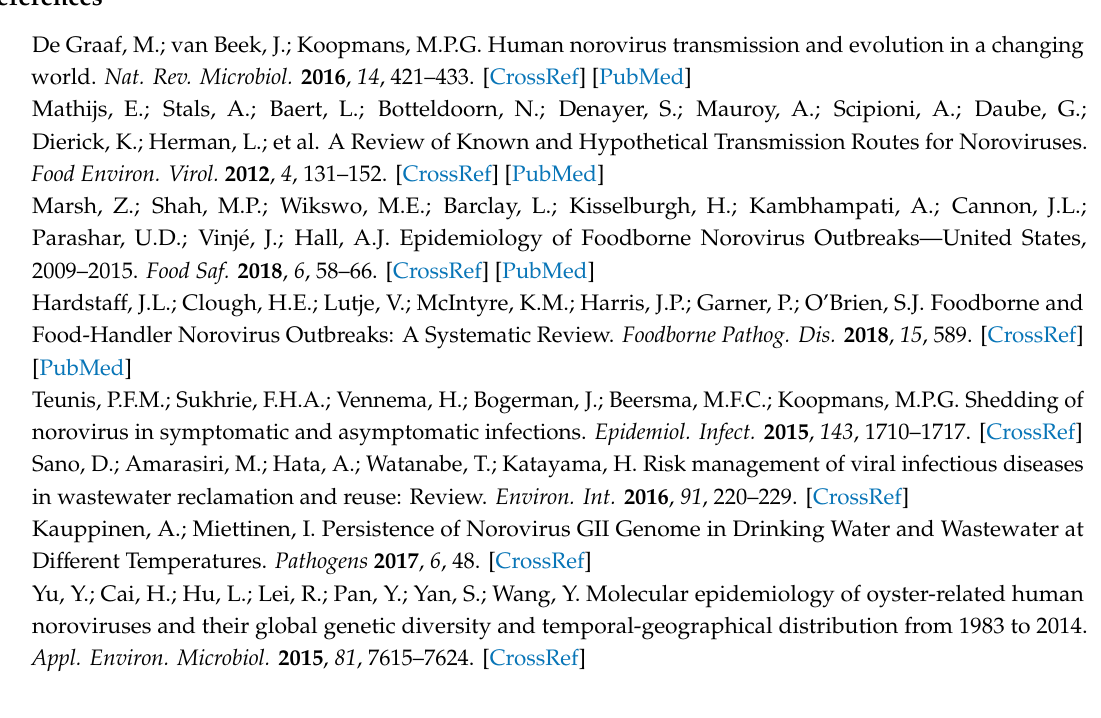
Table S1: Genotype or P-type and accession number of NoV references used for